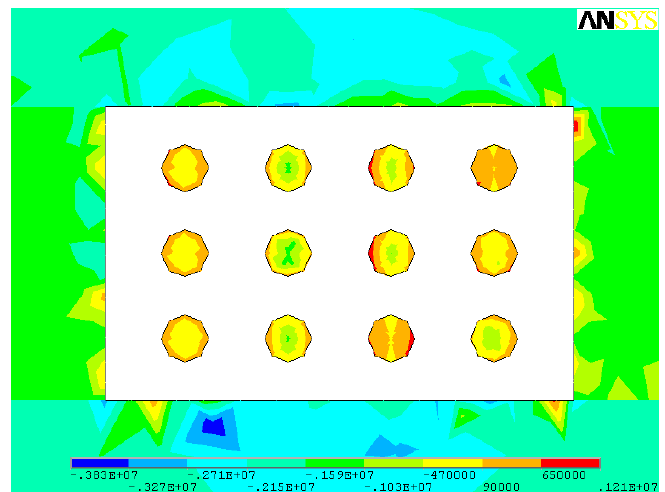
Figure 36. Maximum principal stress distribution in the middle of the pillar at 1480 mL of scheme 9 (parameters of scheme 9: stope height 4.5 m, pillar diameter 4 m, pillar spacing 7 m, pillar row spacing 8 m).